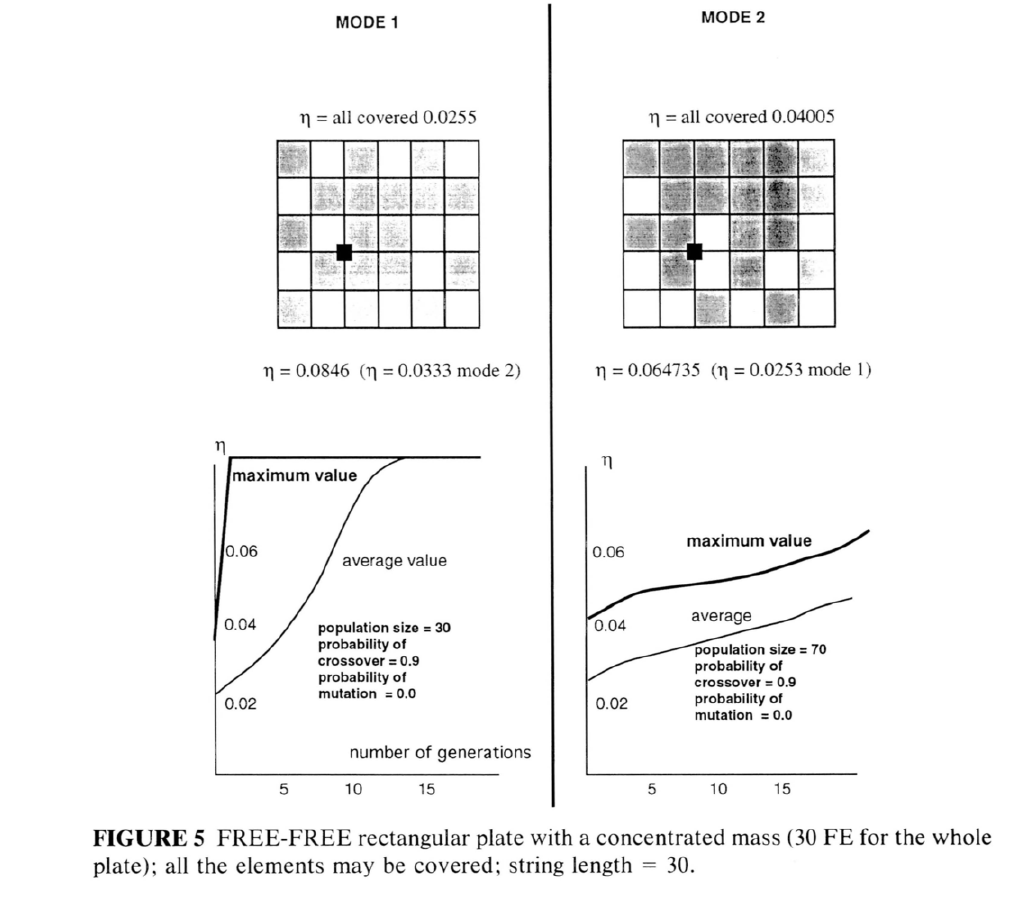
FIGURE 5 FREE-FREE rectangular plate with a concentrated mass (30 FE for the whole plate); all the elements may be covered; string length 30.